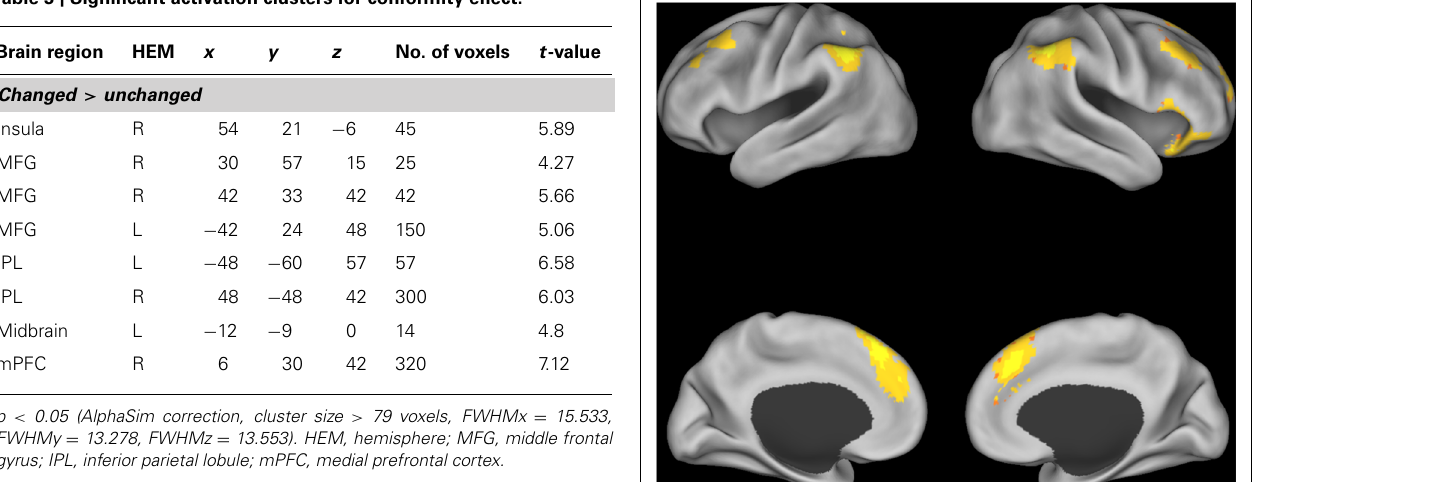
Table 3 | Significant activation clusters for conformity effect.